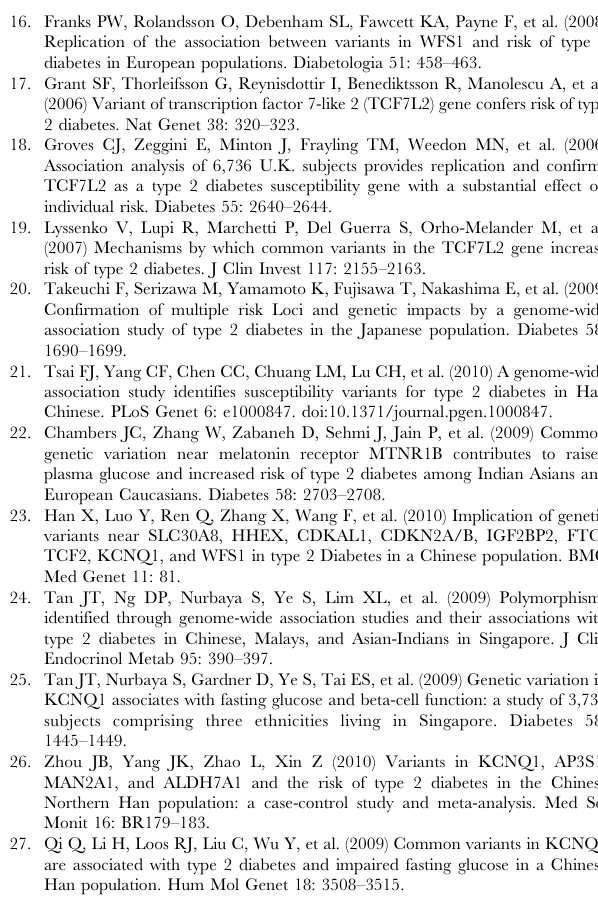
the number of SNPs within 500kb exhibiting evidence of P - value , 10 2 4 . Genomic control (GC) inflation factors for each population are also reported. Table S2 Statistical evidence of the top regions (defined as P - value , 10 2 5 ) that emerged from the fixed-effects meta-analysis of the GWAS results across Chinese, Malays and Asian Indians presented for each ethnic group. Table S3 Known Type 2 Diabetes susceptibility loci tested for replication in the three Singapore populations separately and combined meta-analysis. Published ORs are obtained from European populations and correspond to the established ORs in Figure 2. Risk alleles are in accordance with previously established risk alleles and with information on whether each SNP is a directly observed genotype (1) or is imputed (0) or (.) is not available for analysis. Power (%) refers to the power of the individual studies to detect the published ORs at an a -level 0.05, given the allele frequency and sample sizes observed in our own studies.